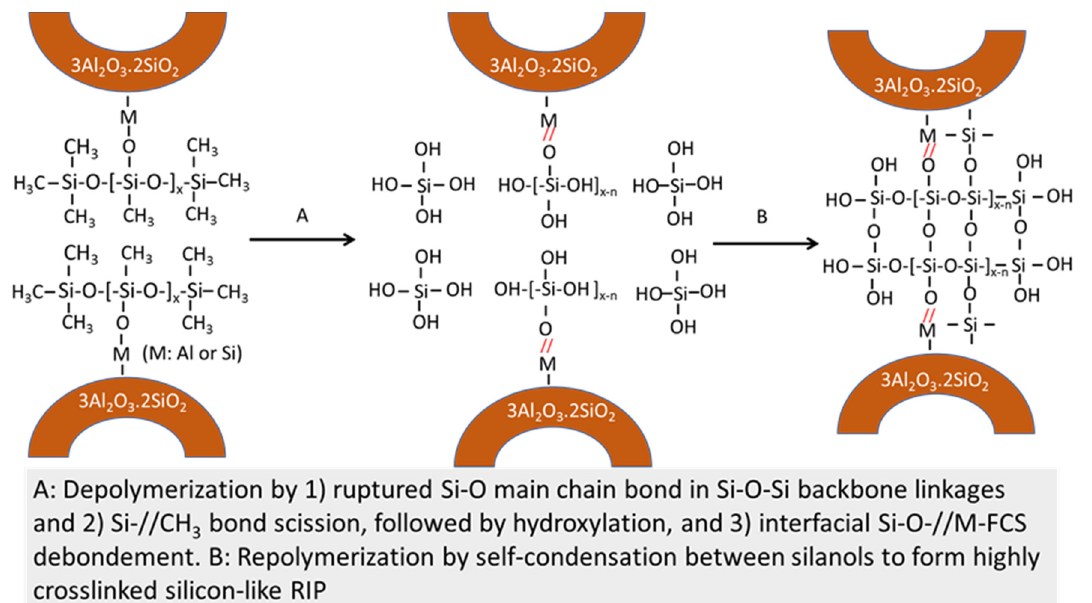
Figure 14. Depolymerization → repolymerization of PMHS debonded from the FCS surfaces at 250 °C.